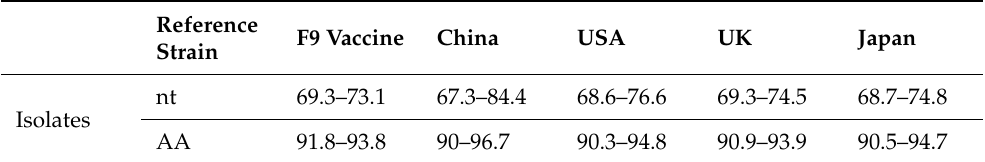
Table 3. Comparison of Nt and AA homology between FCV strains with reference strains. All data were presented in percentages.